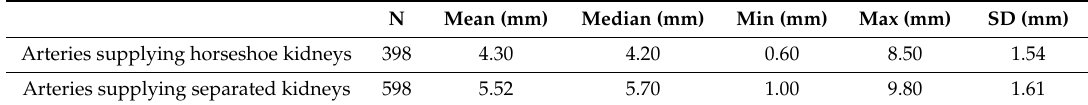
Table 1. The diameters of renal arteries in examined and control